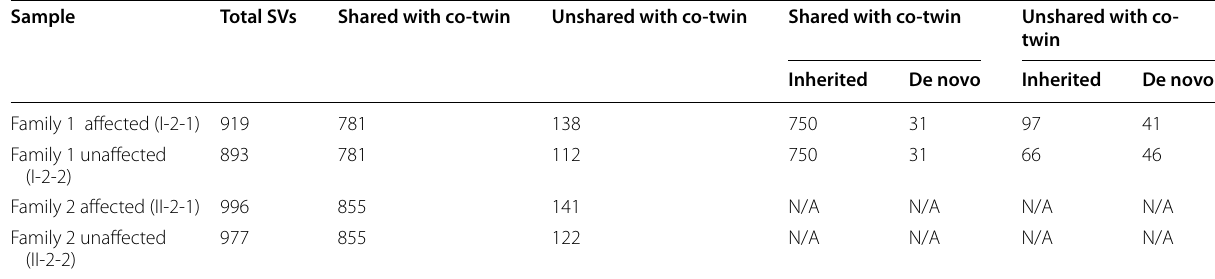
Table 8 Shared and unshared structural variation (SV) as compared to NCBI Build 37